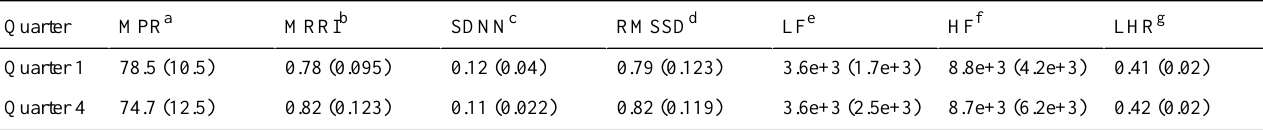
Table 4. Mean (SD) values of measures in primary analysis including trainees only (XeY denotes scientific